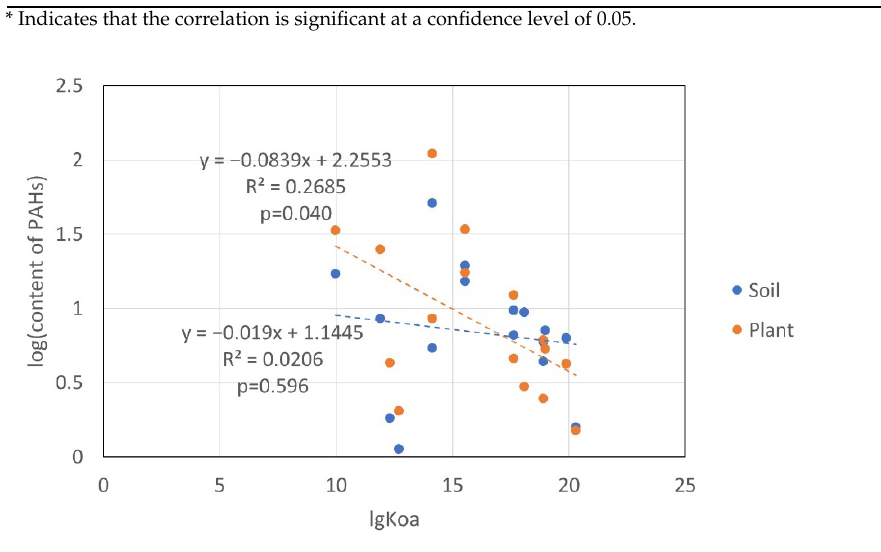
Table 6. Correlation between the contents of PAHs in soil and plants and their Kow and Koa values. lg(PAHs in Soil) lg(PAHs in Plants) r lgKow − 0.071